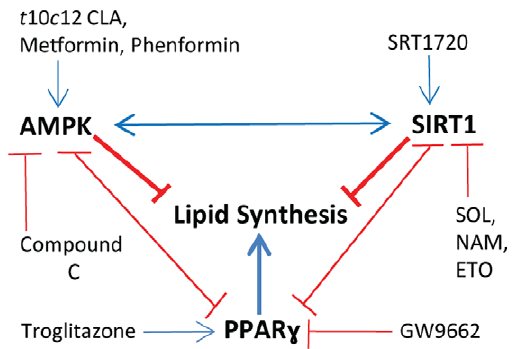
Figure 8. Summary diagram for proposed effects of AMPK, SIRT1, PPAR c , and their activators or inhibitors in 3T3-L1 adipocytes. AMPK and SIRT1 impair lipid synthesis and PPAR c activity (red lines with stop bars), and stimulate each other (blue arrows). PPAR c impairs AMPK and SIRT1 activity and stimulates lipid synthesis. The activating (blue arrows) or inhibiting (red line with stop bar) effects of the different chemical activators and inhibitors are also shown.